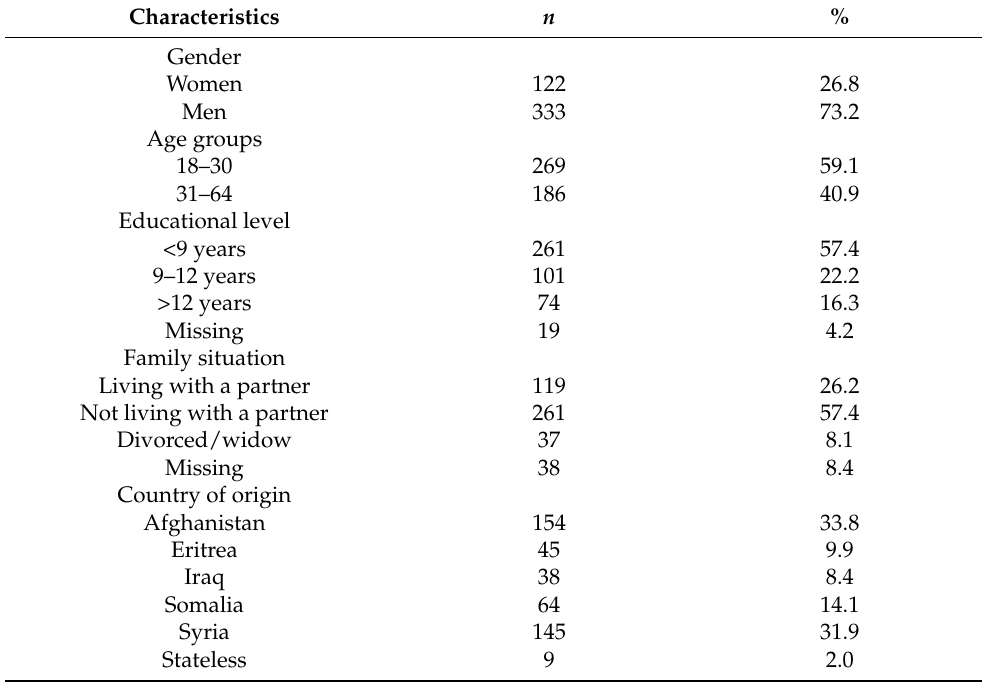
Table 1. Sociodemographic characteristics of the asylum seeker cohort in Sweden (N = 455).